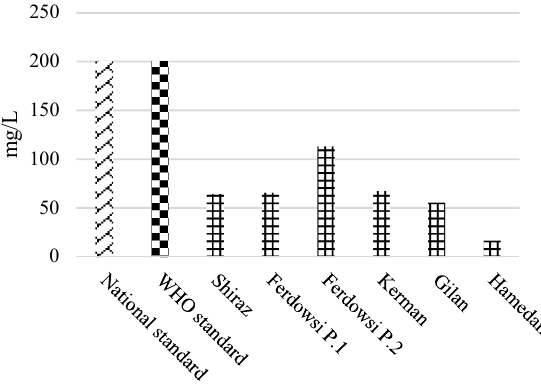
Fig. 4. Comparison of the amount of sodium to the national and global